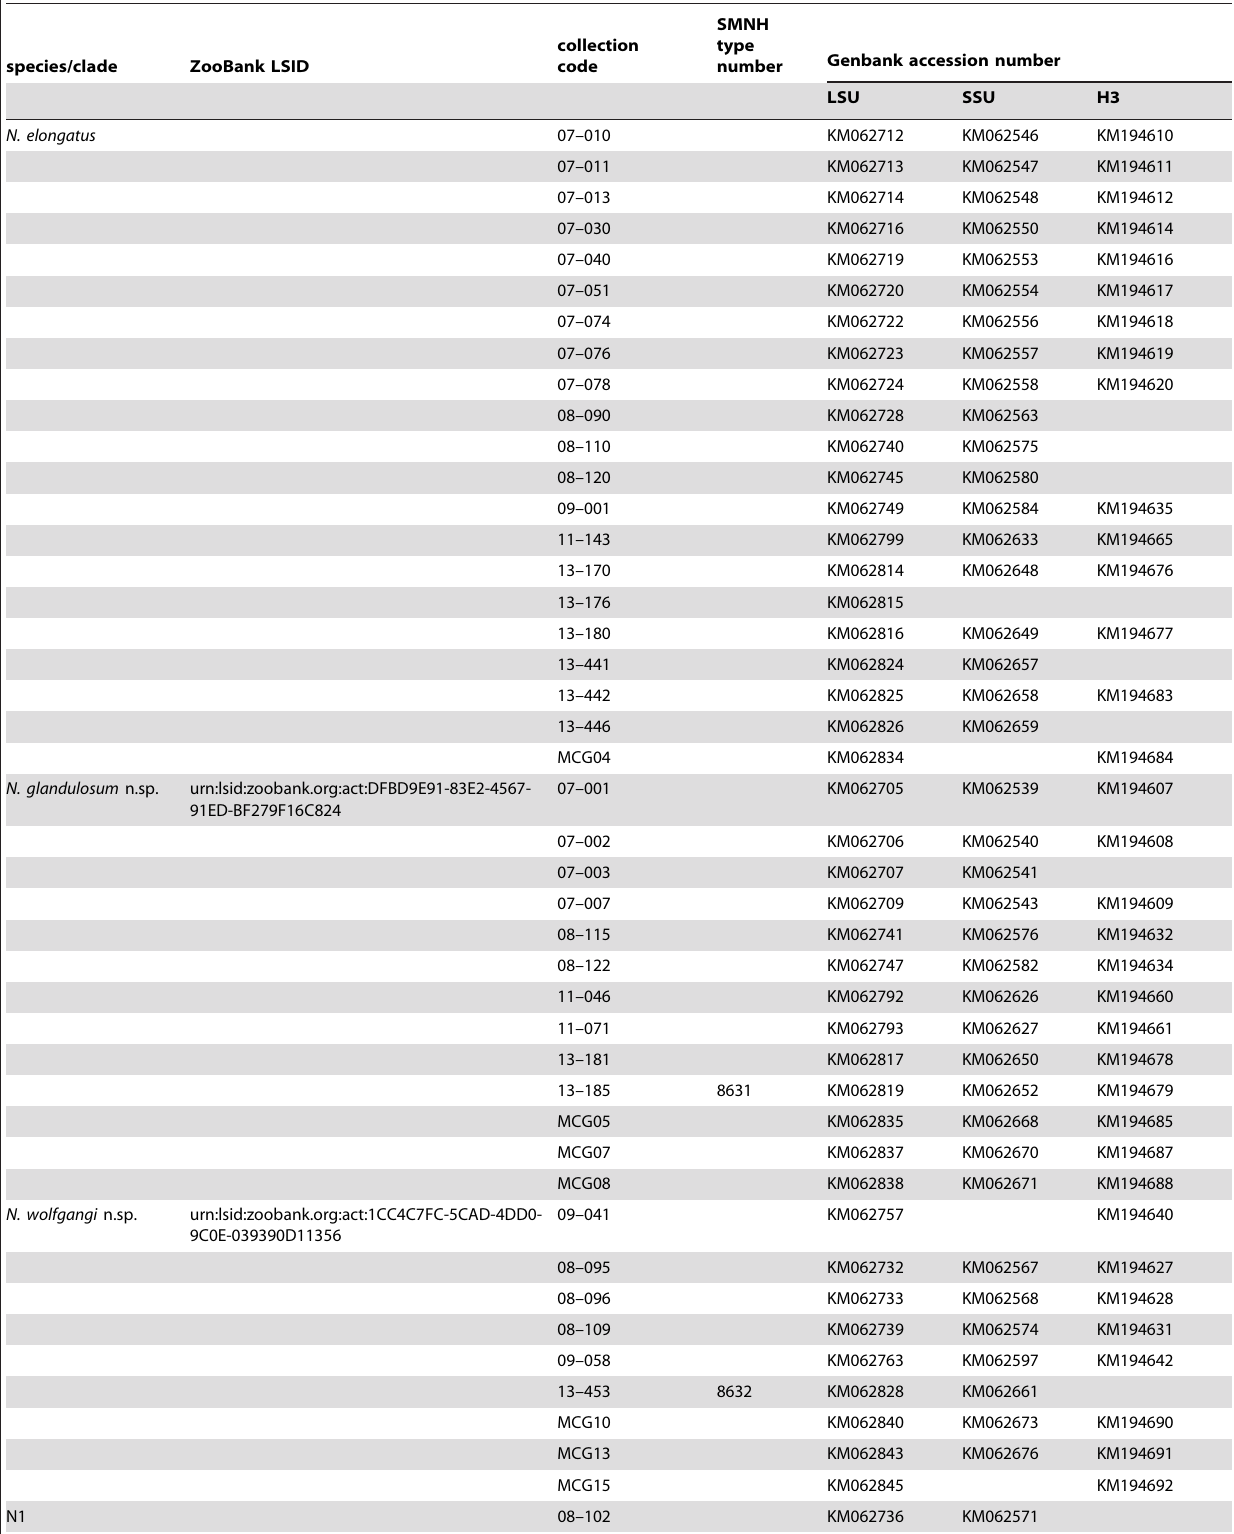
Table 2. List of all individuals used in this study sorted by clade, with Zoobank Life Science Identifiers (LSID) where applicable, connecting collection code (used in the scratchpads database for Acoela and Nemertodermatida at http://acoela.myspecies.info/), genbank accession numbers per gene and the museum collection numbers for type